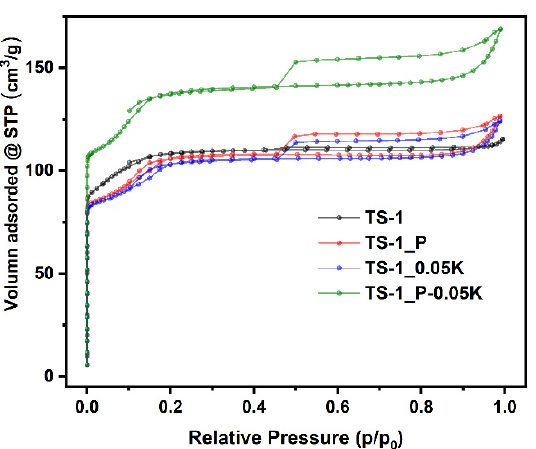
Figure 3. N 2 adsorption/desorption isotherms of various TS-1 zeolites.